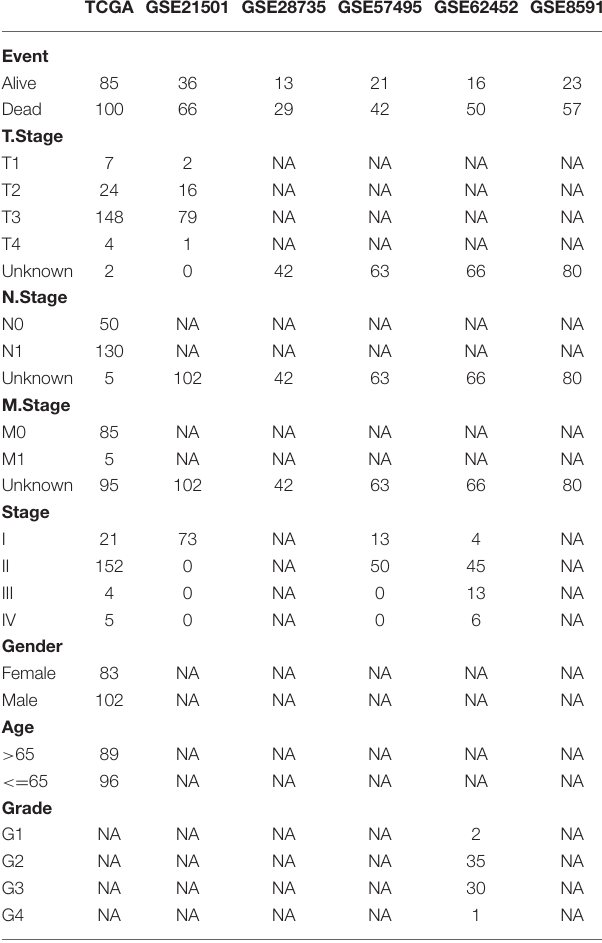
TABLE 1 | Clinical characteristics of each